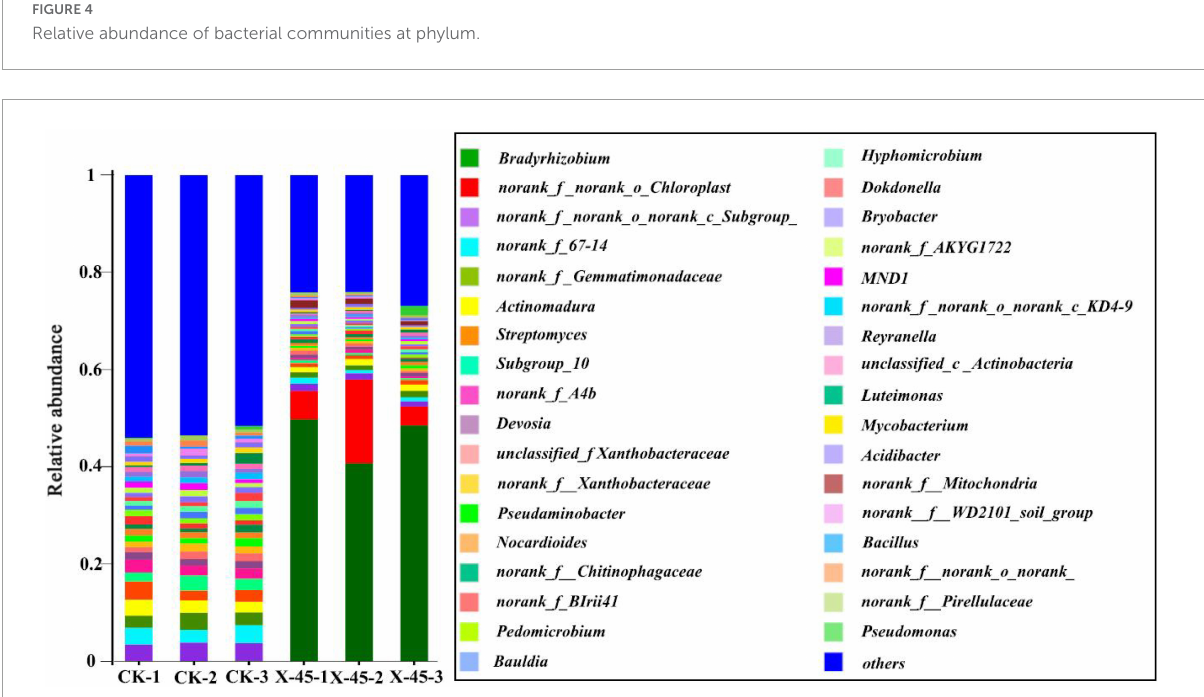
FIGURE5 Relative abundance of bacterial communities at genus